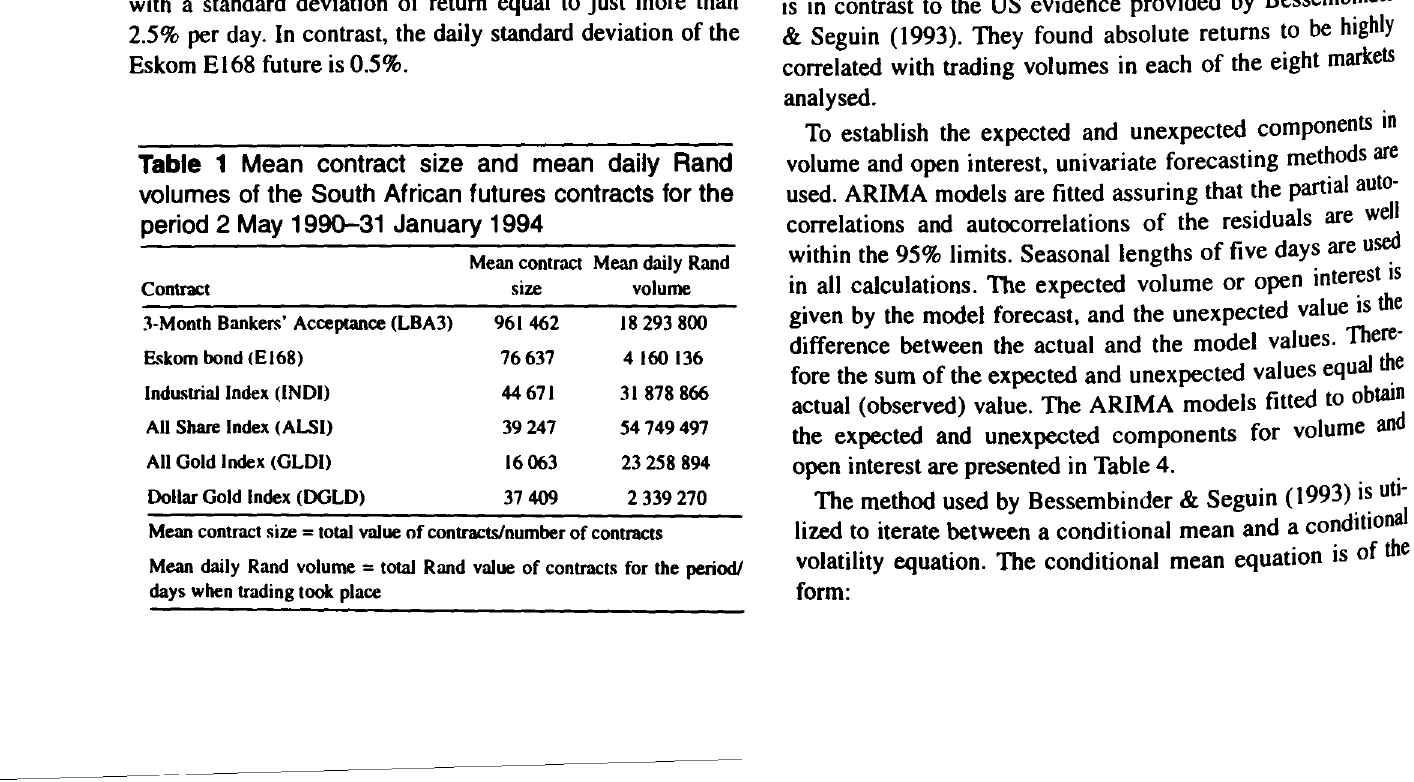
Table 1 Mean contract size and mean daily Rand volumes of the South African futures contracts for